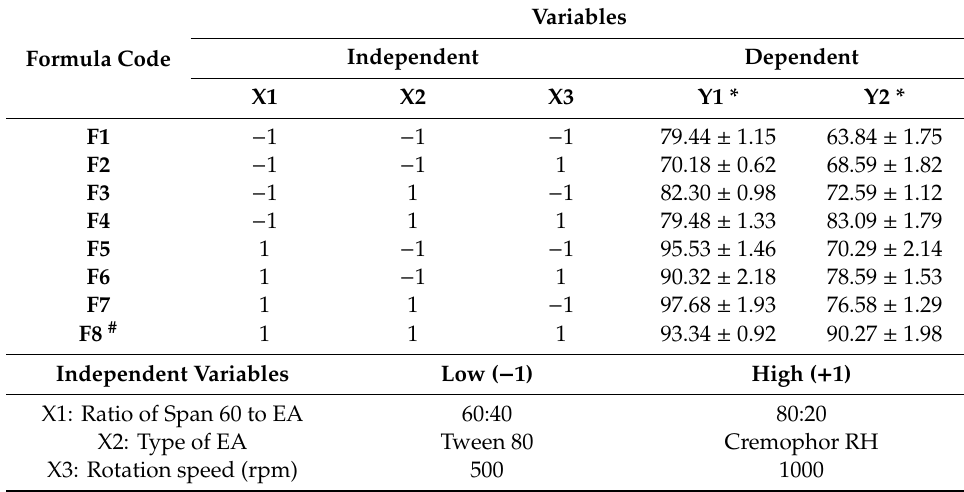
Table 1. Experimental runs, independent variables and measured responses in 2 3 factorial design for SV-loaded